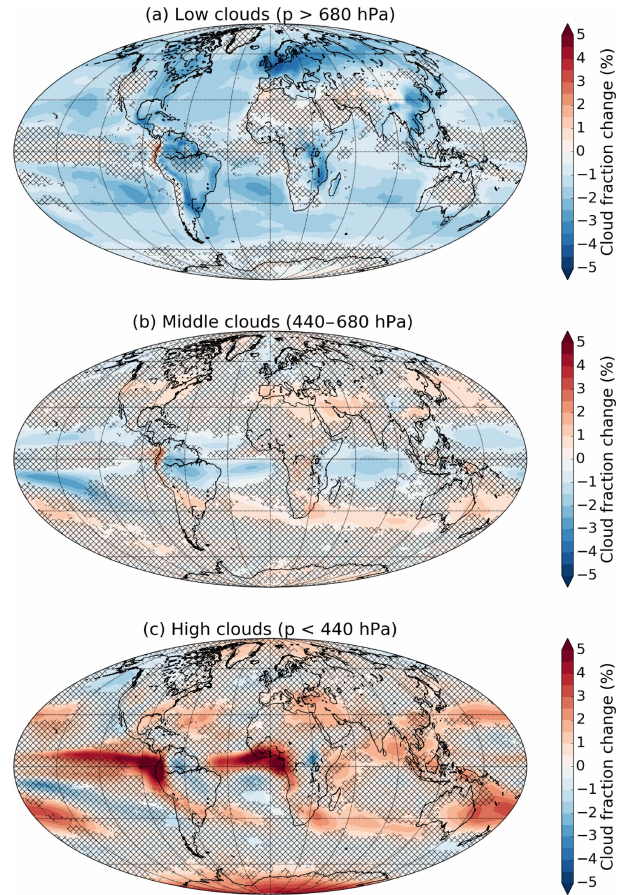
Figure 5. Multi-model mean changes in low (a) , middle (b) , and high (c) cloud fraction for G1 – piControl. Hatching indicates areas where fewer than 9 of the 11 models agree on the sign of the change.